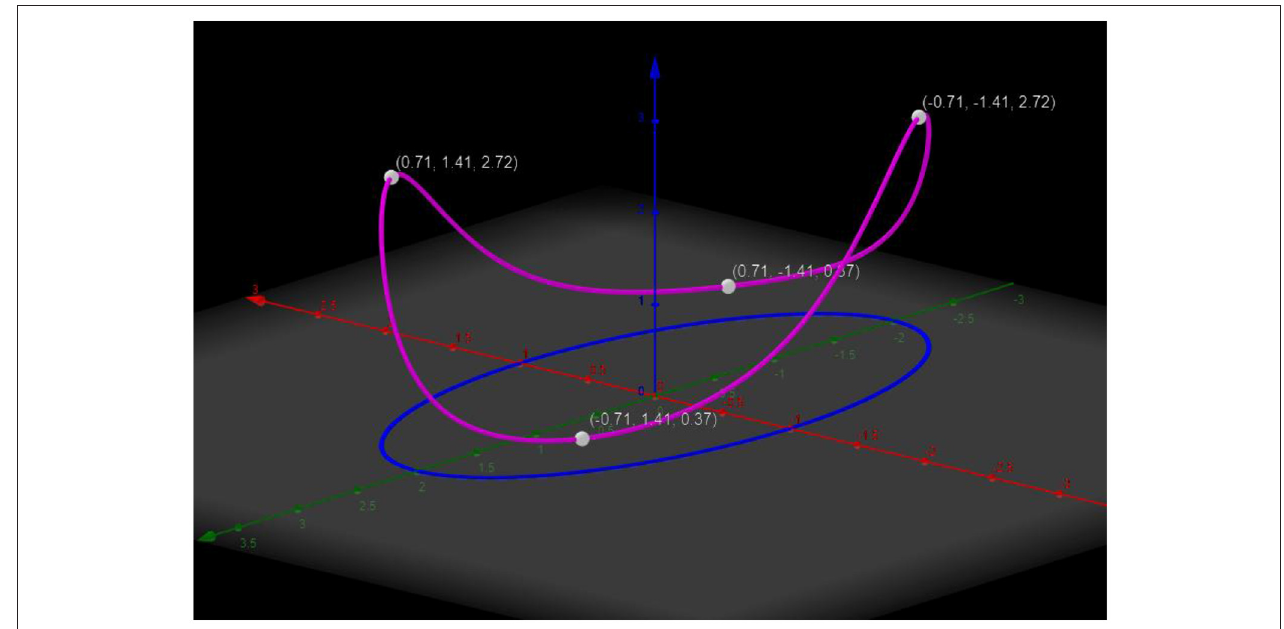
FIGURE 1 | Example constructed using